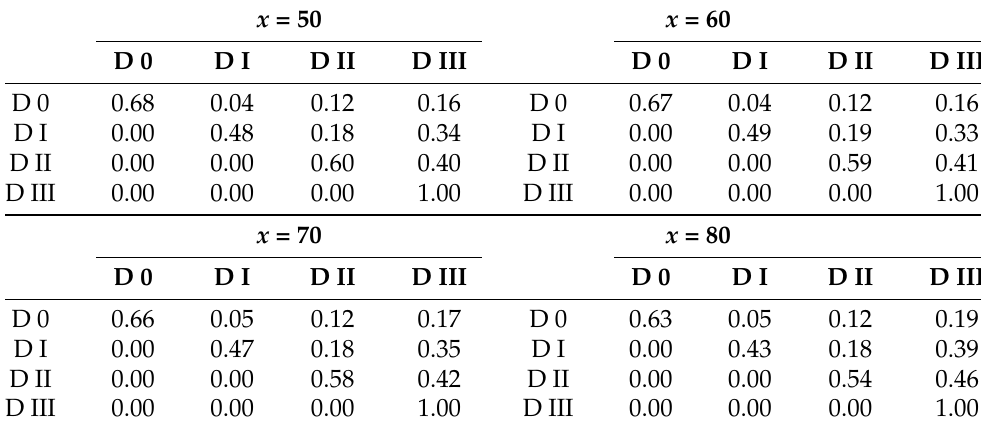
Table 4. Transition probabilities starting at certain ages (women).